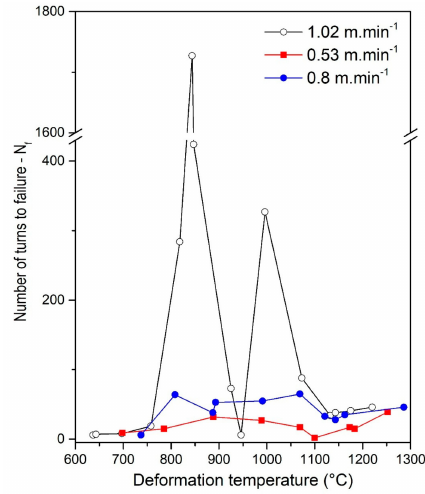
Figure 16. Temperature dependence of hot ductility (number of turns to fracture, N f ) in torsion testing for three slab pulling rates: v = 0.53 [36], v = 0.8 [26] and v = 1.02 m /